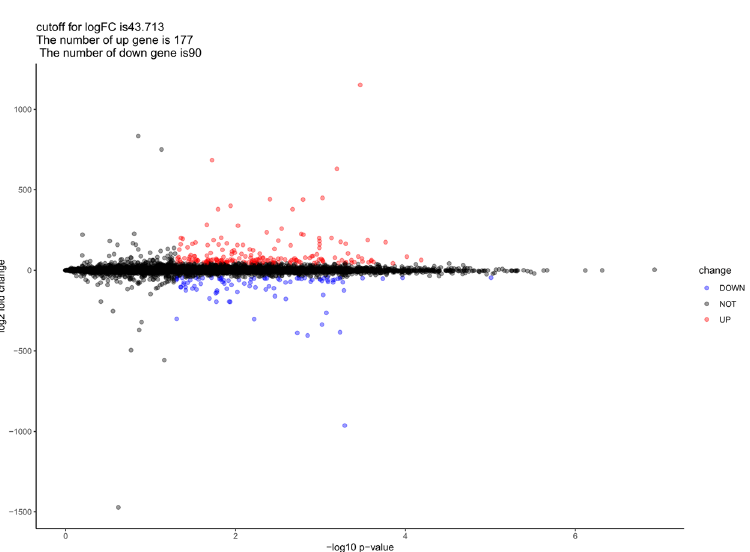
Figure 1. Volcano map of DELs. Up-regulated genes are represented by red spots while down-regulated genes by blue